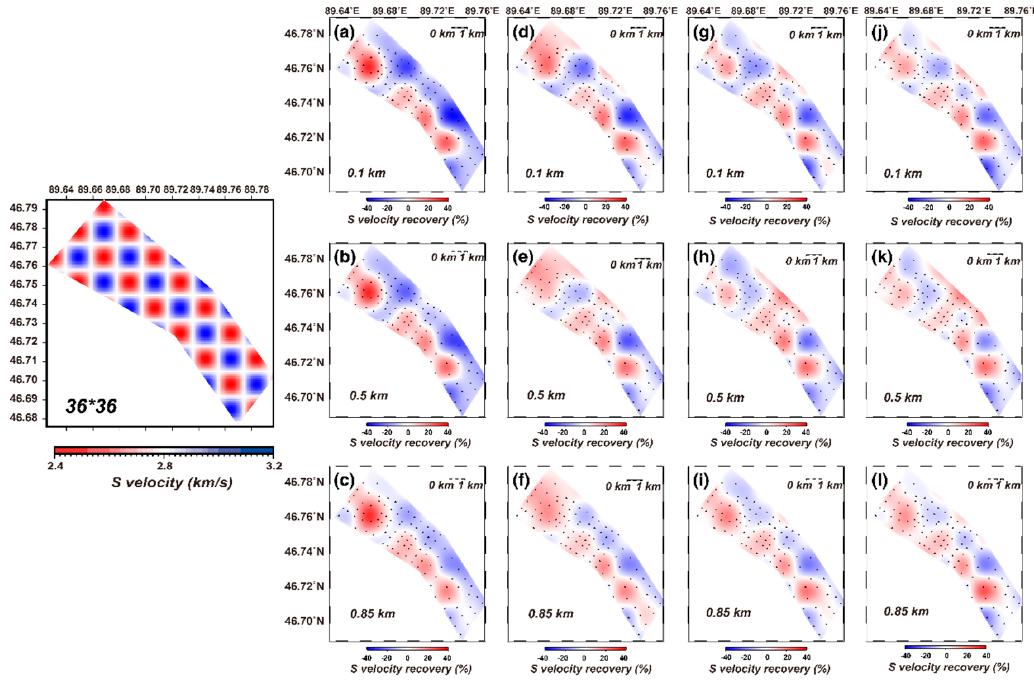
Figure 10. Horizontal resolution tests of numbers of stations. The left panel shows the synthetic model. ( a – c ) the model recoveries with 50 stations at depth of 0.1, 0.5 and 0.85 km in order. ( d – f ) the model recoveries with 70 stations at depth of 0.1, 0.5 and 0.85 km in order. ( g – i ) the model recoveries with 90 stations at depth of 0.1, 0.5 and 0.85 km in order. ( j – l ) the model recoveries with 100 stations at depth of 0.1, 0.5 and 0.85 km in order.